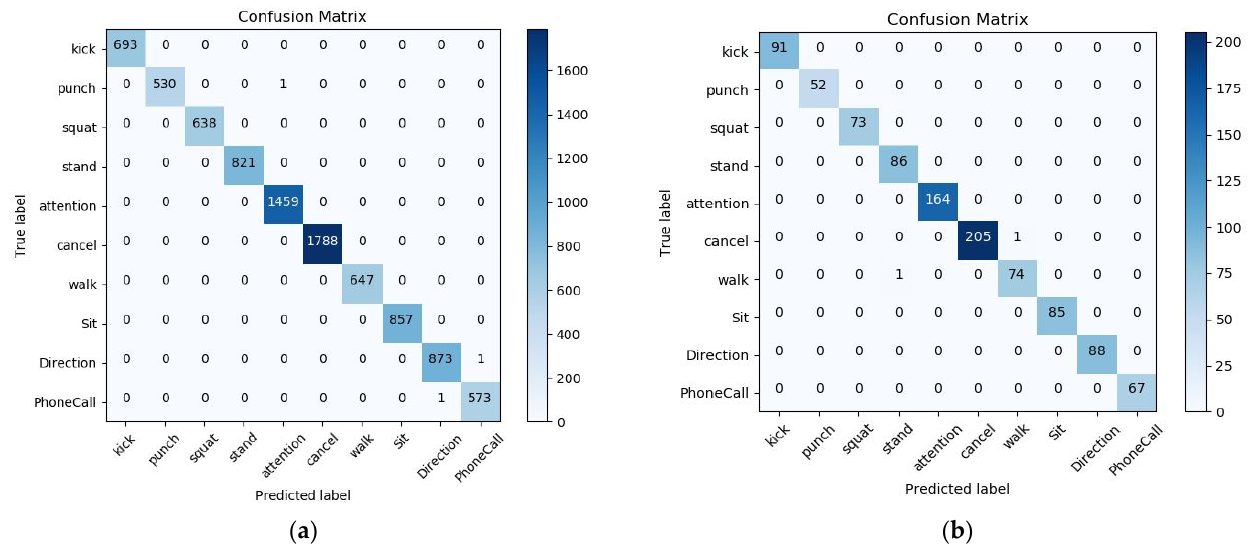
Figure 9. Confusion matrix with predicted labels on X -axis and true labels on the Y -axis tested on body gesture training set ( a ) and in testing dataset ( b ).